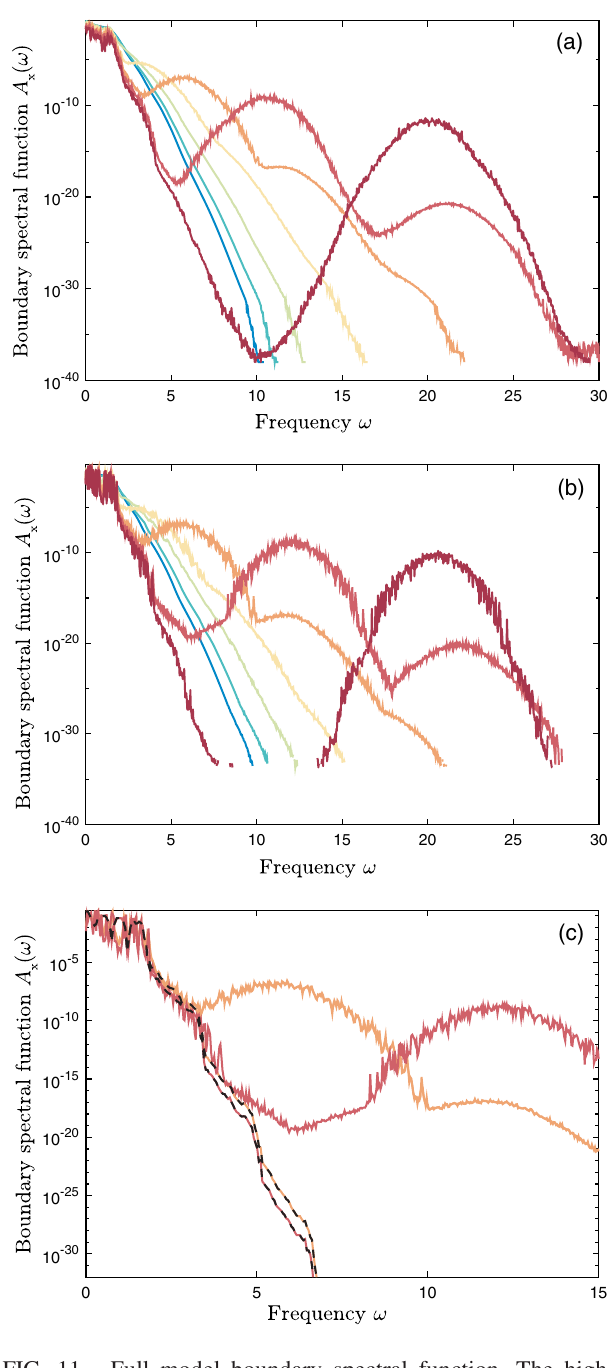
FIG. 11. Full model boundary spectral function. The high- frequency part of the spectral function of the S x operator on the boundary of a chain with three impurities placed at every fourth site. Color goes from blue to red with increasing V . (a) shows the typical spectrum obtained by averaging log A ten different samples, and (b) shows one of those samples. (c) shows a comparison to the effective model spectrum shown in Fig. 3(b) for V ¼ 40 2 = 3 = 2 and V ¼ 40 5 = 6 = 2 in orange and red,